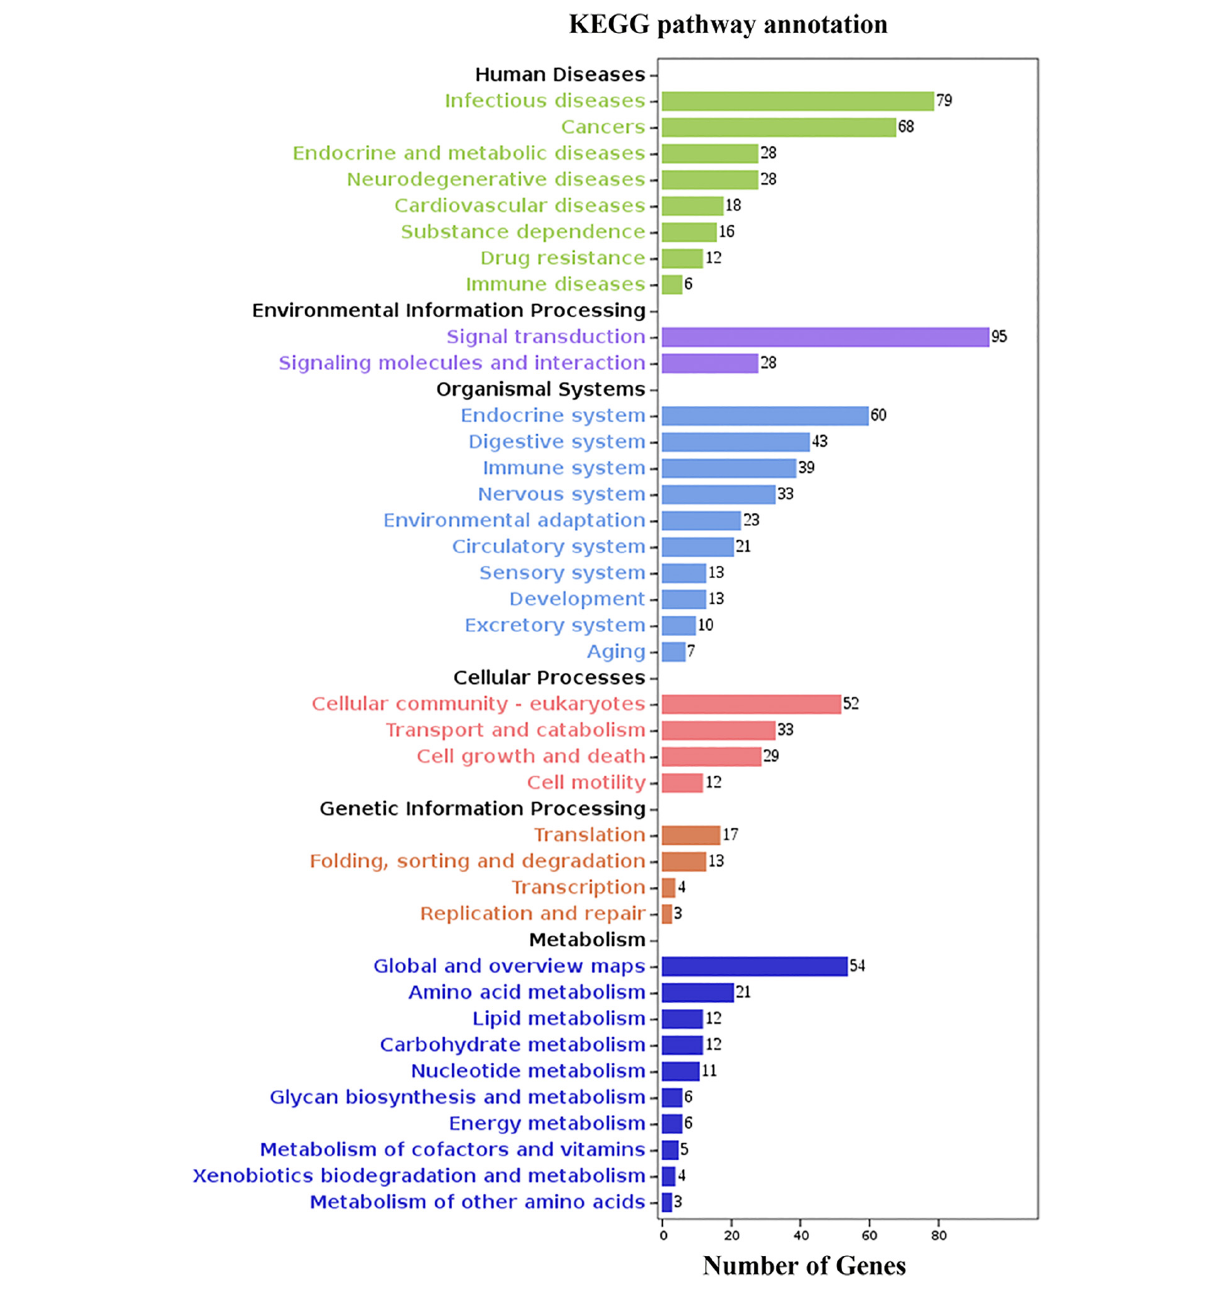
FIGURE 6 | KEGG analysis of DEGs. The y -axis indicates level-2 KEGG classes; the x -axis represents the corresponding number of